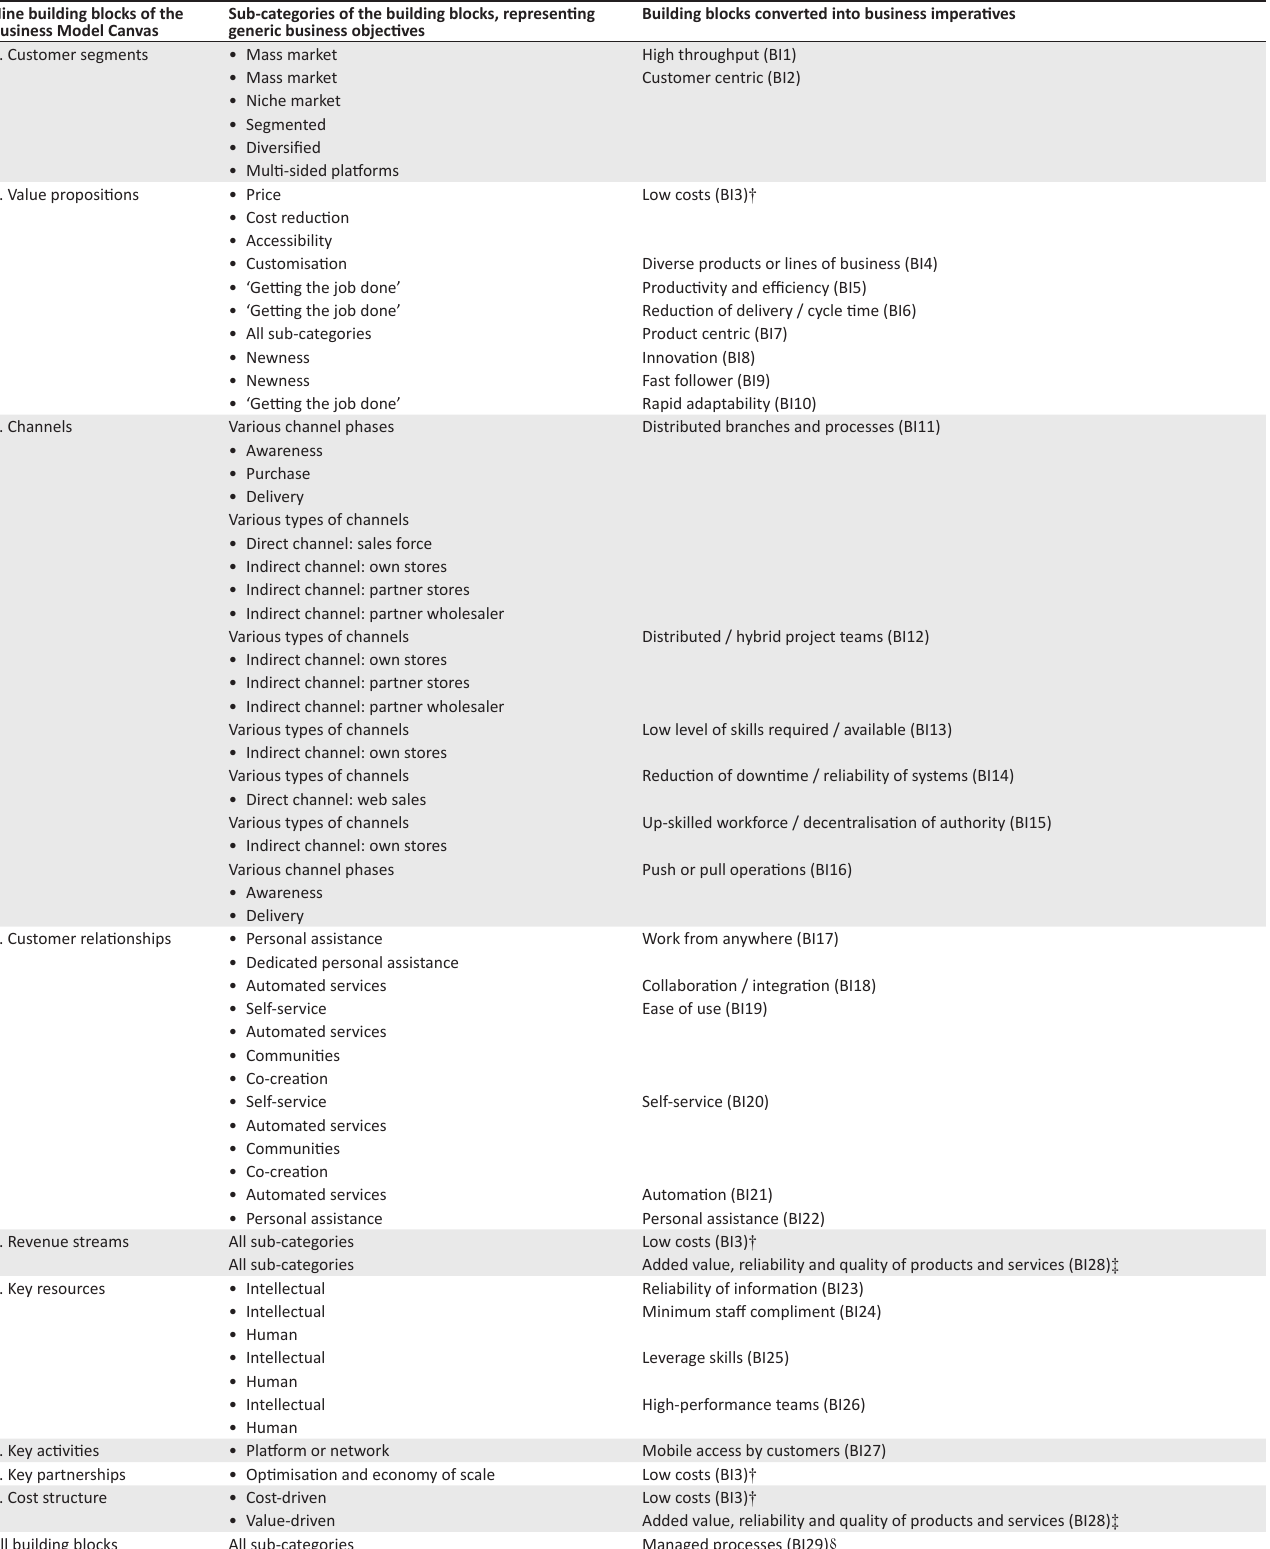
TABLE 1-A1: Conversion of the building blocks of the Business Model Canvas into business imperatives. Nine building blocks of the Business Model